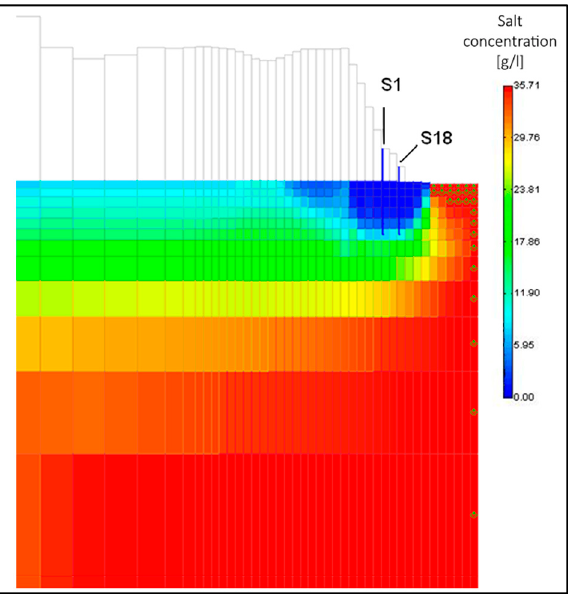
Figure 14. Concentration distribution of the calibrated model (kg/m 3 ) simulated for November 2010 (zoom on the northern part of section AA); green dots indicate cells hosting the boundary condition.